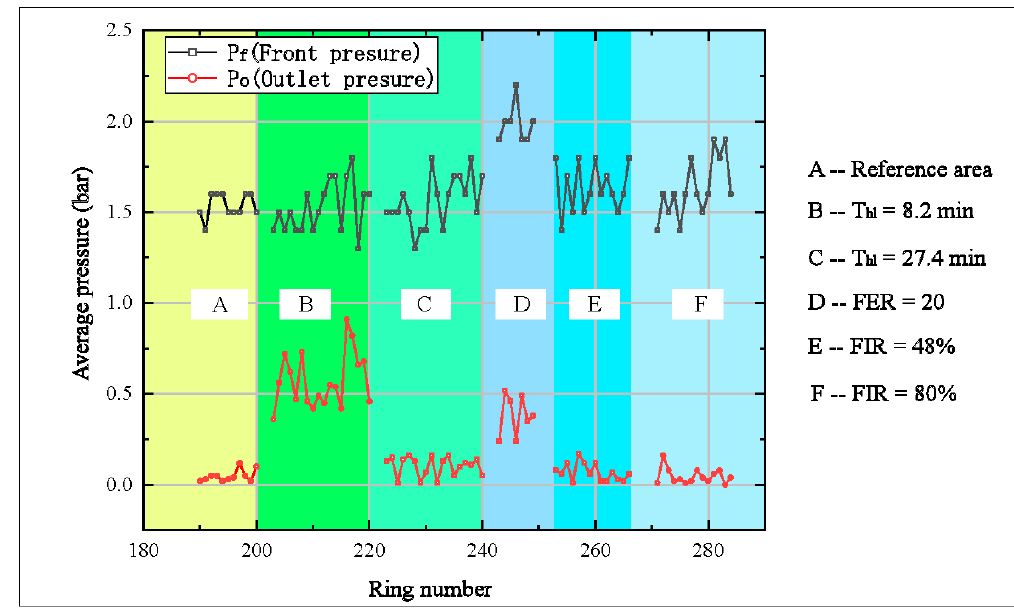
P from the 190th to 285th rings. Figure 11. The average of P P and o and P f from the 190th to 285th f o